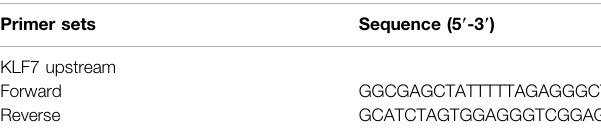
TABLE 2 | Primer sets for ChIP-qPCR